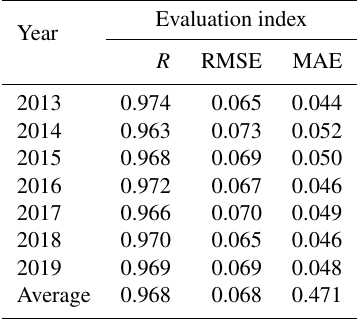
Table 2. Evaluation indexes of the simulated patches between 2013 to